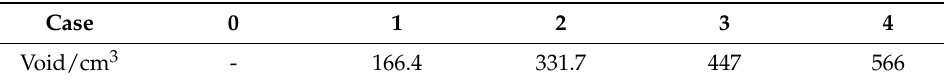
Figure 6. Damage Setup. Table 2. Test conditions.